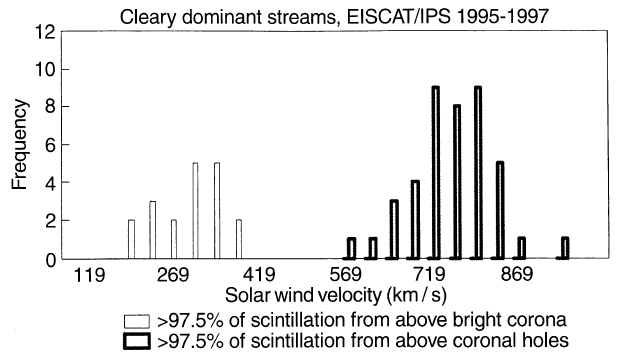
Fig. 6. Velocity distribution of clearly dominant streams (contribut- ing >97.5% of observed